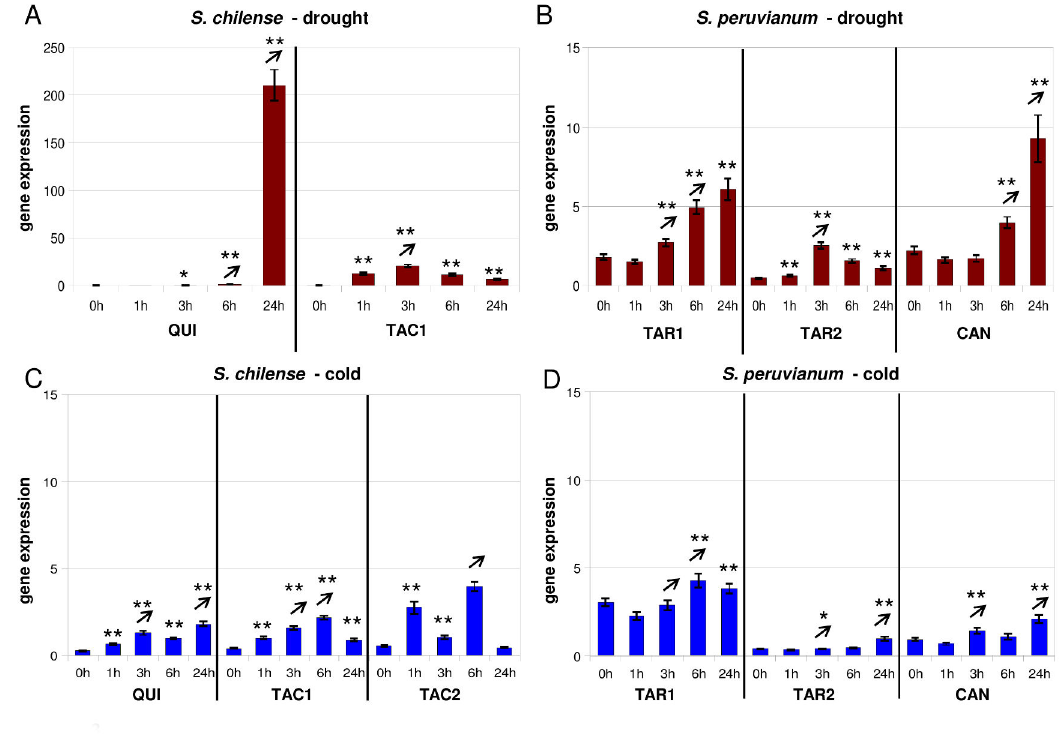
Figure 3. Gene expression of Asr4 after application of drought and cold stress. (for explanation see Figure 1). doi: